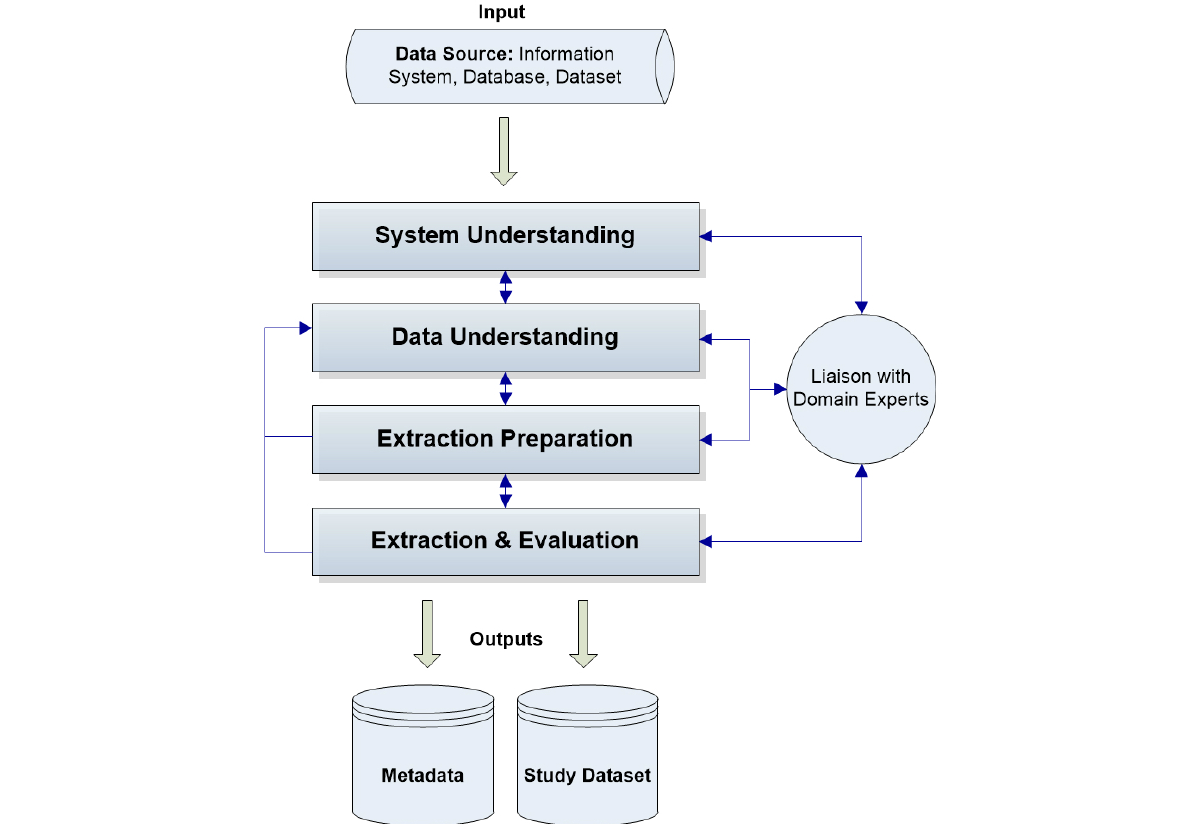
Figure 1. Simplification of the data extraction process